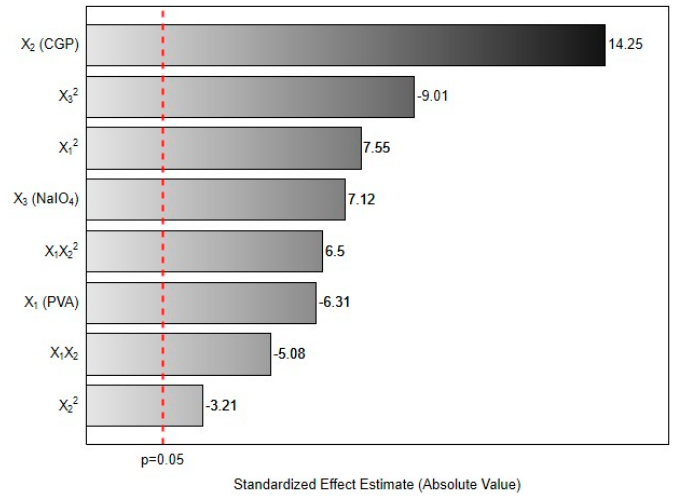
Figure 1. Pareto chart of the main effects obtained from 3 3-1 fractional factorial design for released carbohydrates determination.